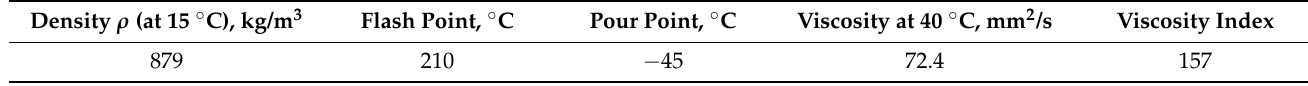
Table 3. Basic physicochemical properties of SAE 75W-85 gear